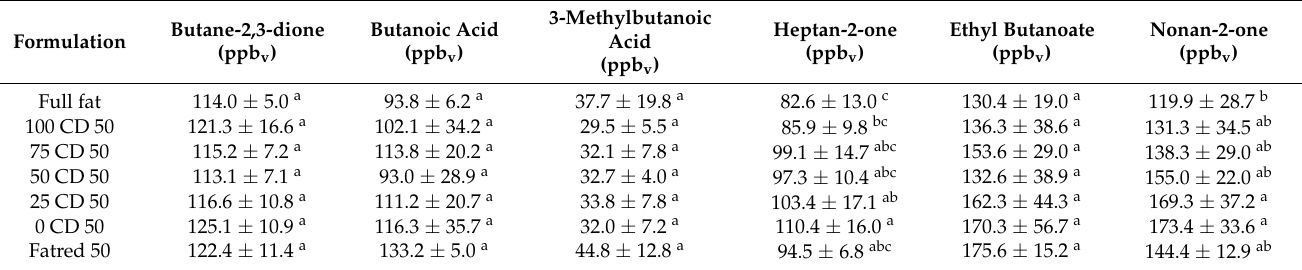
Table A2. Concentrations of the six target aroma compounds in the headspace gas of the full-fat sample and the samples with 50% fat reduction.